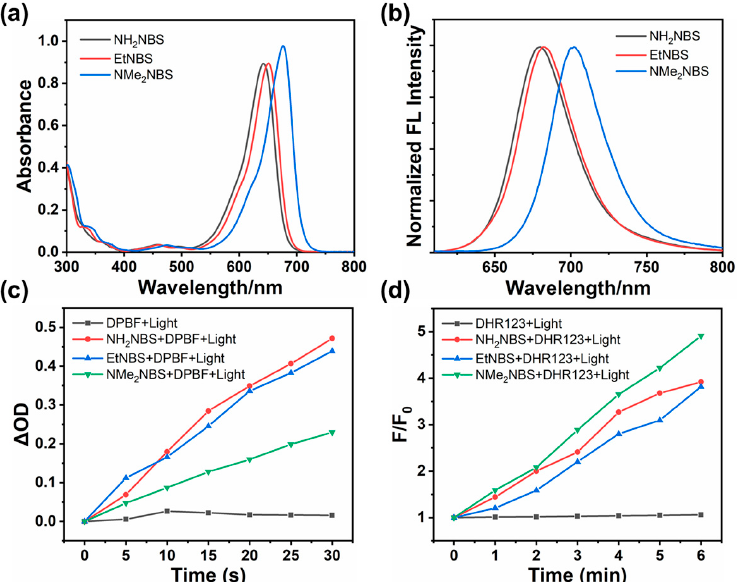
Figure 1. ( a ) Absorption and ( b ) normalized emission spectra of NH 2 NBS, EtNBS, and NMe 2 NBS in dichloromethane solution. ( c ) The bleaching rates of DPBF by photoinduced 1 O 2 in MeOH ( Δ OD represents the absorption difference of DPBF at 410 nm before and after 635 nm laser irradiation). ( d ) The oxidation rate of DHR 123 by the photoinduced O 2 − • radical in the PBS solution (F 0 and F represent the fluorescence intensity of DHR123 at 526 nm before and after 635 nm laser irradiation, respectively). The concentration used for each compound was 10 μΜ .